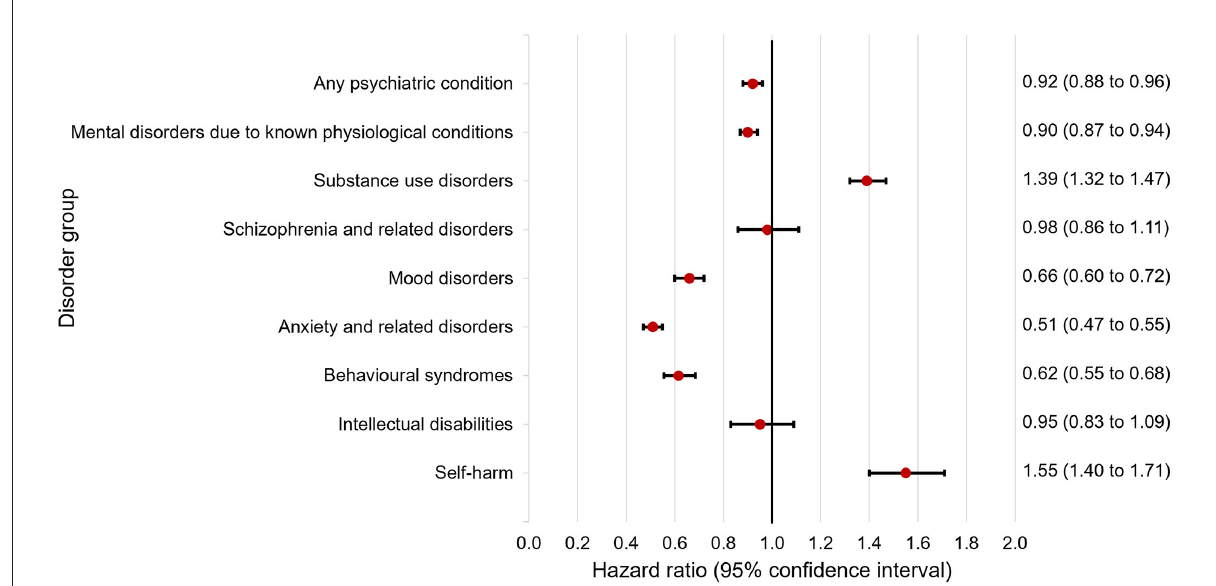
FIGURE1 Hazard ratios for death by specific disorder groups after adjustment for age, sex, hospitalizations, days hospitalized, and the epilepsy-specific comorbidity